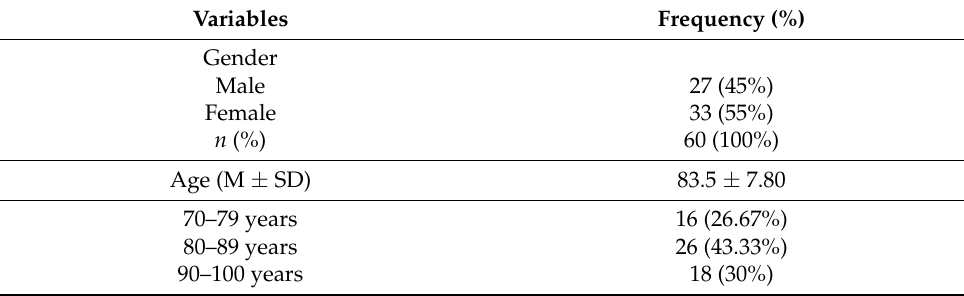
n , sample size; M, mean; SD, standard